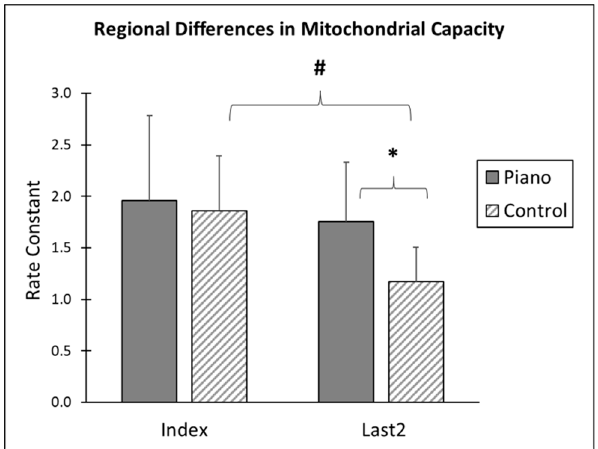
Figure 4. Regional differences in mitochondrial capacity. Control index Rc = 1.86 ± 0.5 and control last two Rc = 1.17 ± 0.3 ( p = 0.001). The last two fingers in piano players showed Rc = 1.76 ± 0.6 and in controls Rc = 1.17 ± 0.3 ( p = 0.01). A 2 × 2 analysis of variance (ANOVA) shows a significant difference between piano players and controls (F = 5.0, p = 0.039), and a significant difference between index and last two finger flexors (F = 12.8, p = 0.02). * and # denote significance.